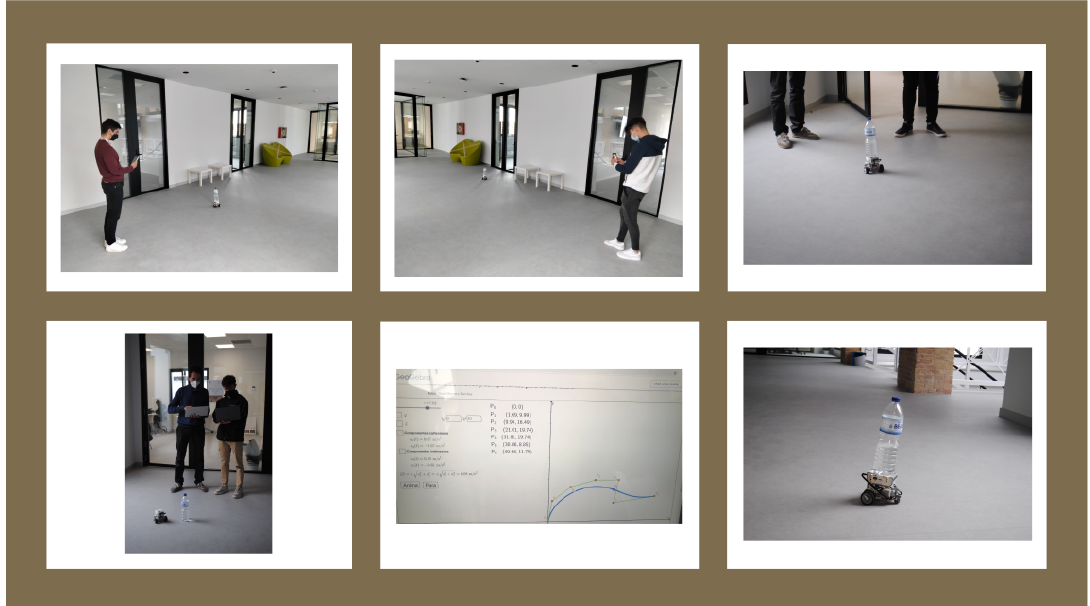
Figure 5. Some pictures of the project with the students.